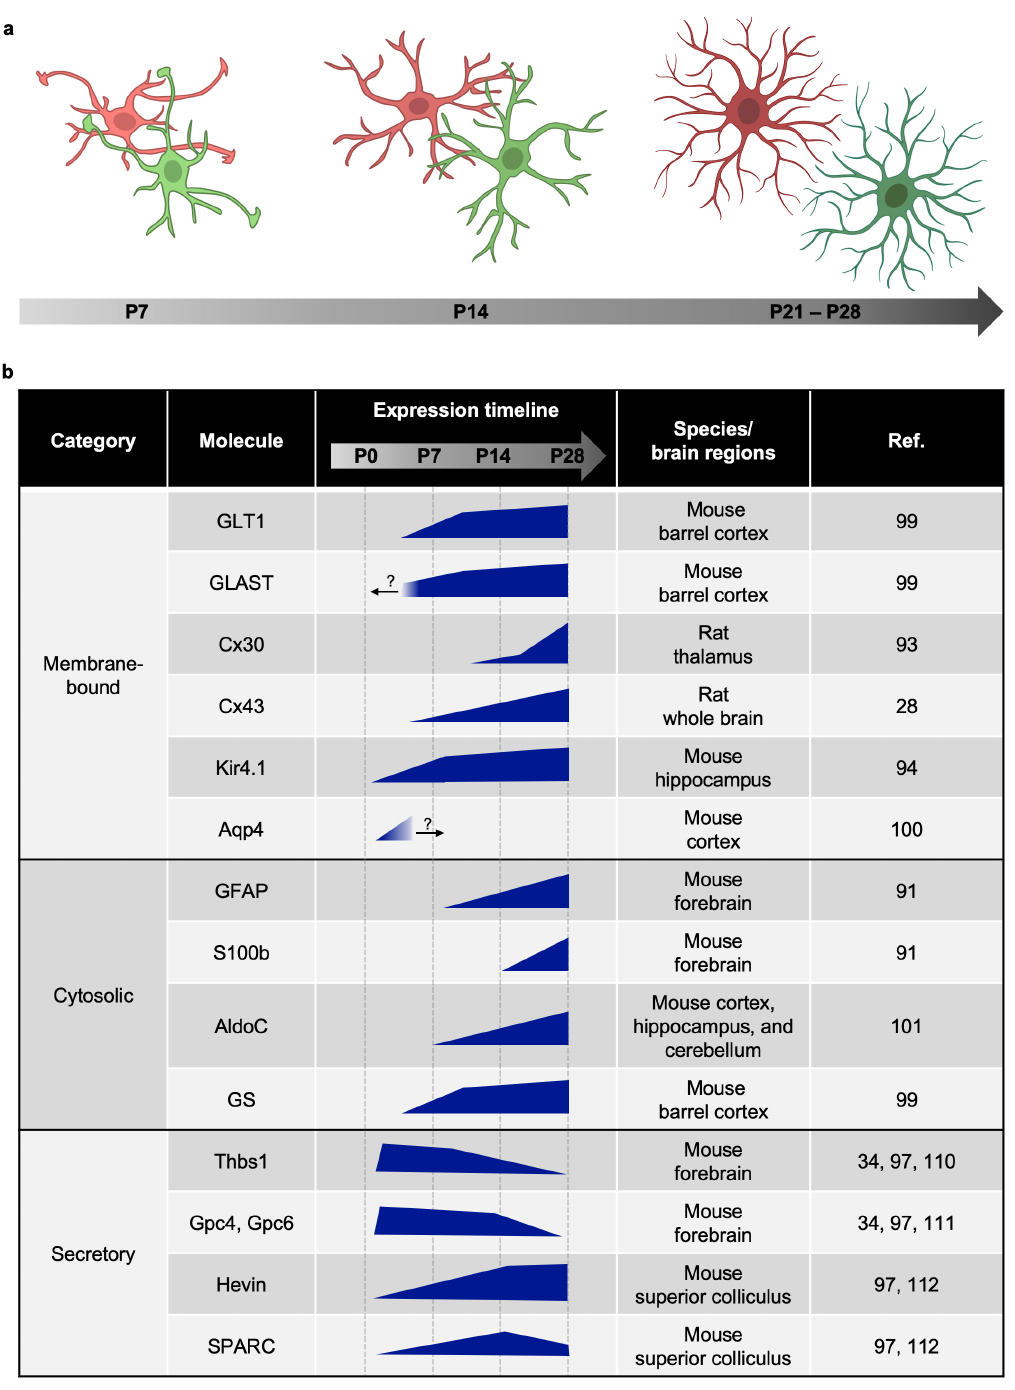
Figure 3. Maturation of astrocytes during postnatal development demonstrated by progressive changes of morphology and gene expression. ( a ) Morphology of astrocytes matures in a stepwise manner. At postnatal day 7 (P7), astrocytes exhibit few branches and the overall morphology is simple and territories are small. Long protrusions are often seen extending into the territories of the neighboring astrocytes. The boundaries of territories are not well-defined yet. At postnatal day 14 (P14), the number of branches become greater and astrocyte territories become bigger. More branch points grow out of existing branches, resulting in more complex morphology. Long protrusions are seen less, and the boundaries of territories start to emerge. At postnatal day 21 to day 28 (P21–P28), astrocytes develop their characteristic “spongiform” complex morphology, and there is minimal overlap between neighboring astrocytes and clear boundary of each territory. ( b ) Genes that are induced during astrocyte maturation. Blue polygons indicate expression levels of the genes during development. Question marks indicate that the expression level beyond the developmental stage is